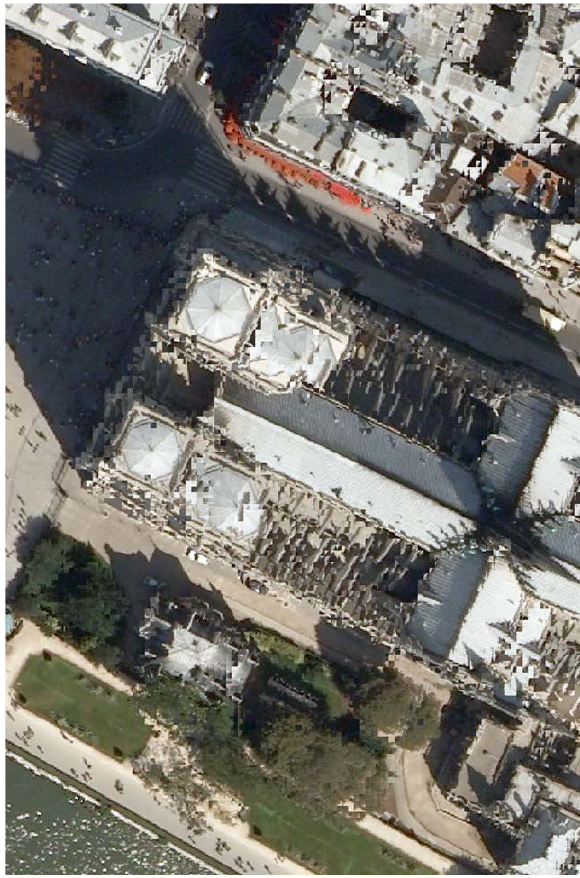
Fig. 12: True orthophoto on an irregular surface (gothic church roof with dublications etc.)